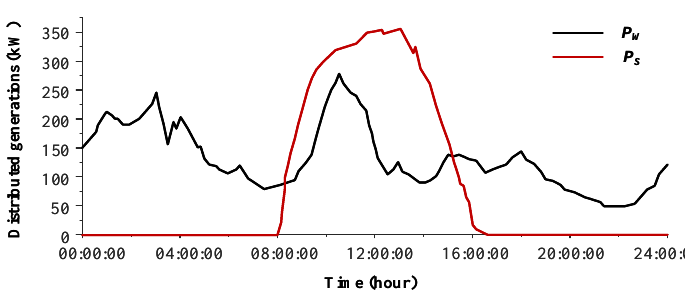
Figure 5. Daily renewable power generation curves.